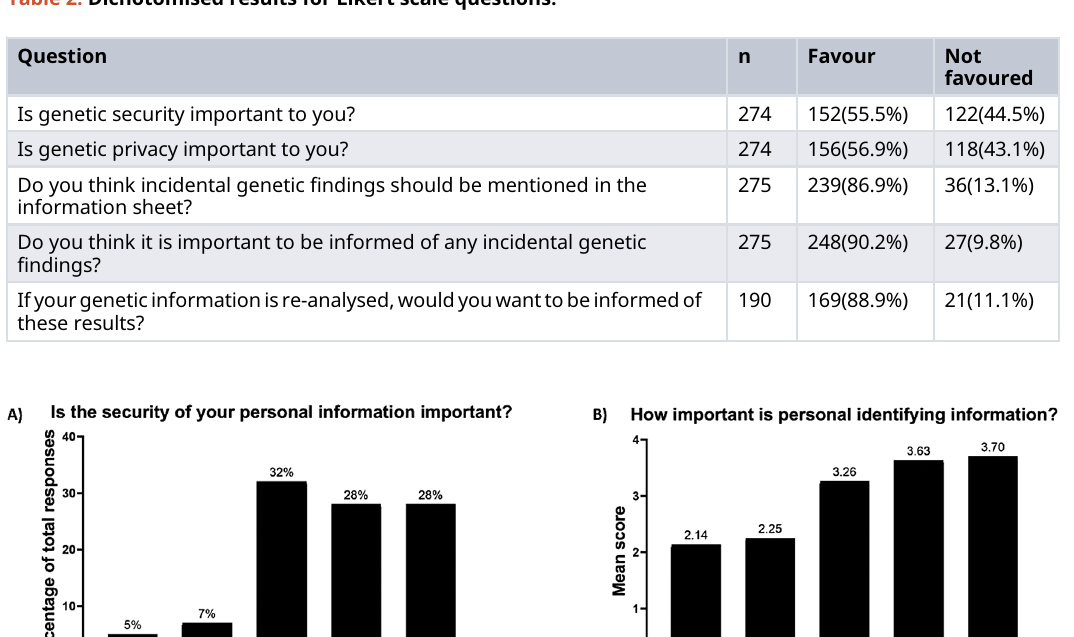
Table 2. Dichotomised results for Likert scale questions.